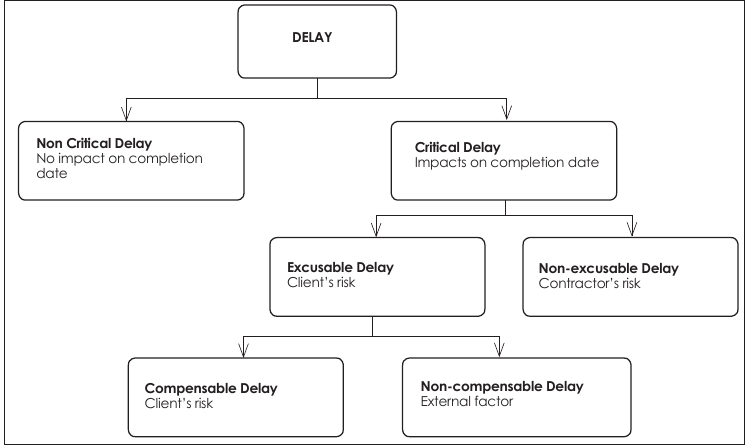
Figure 1: Types of